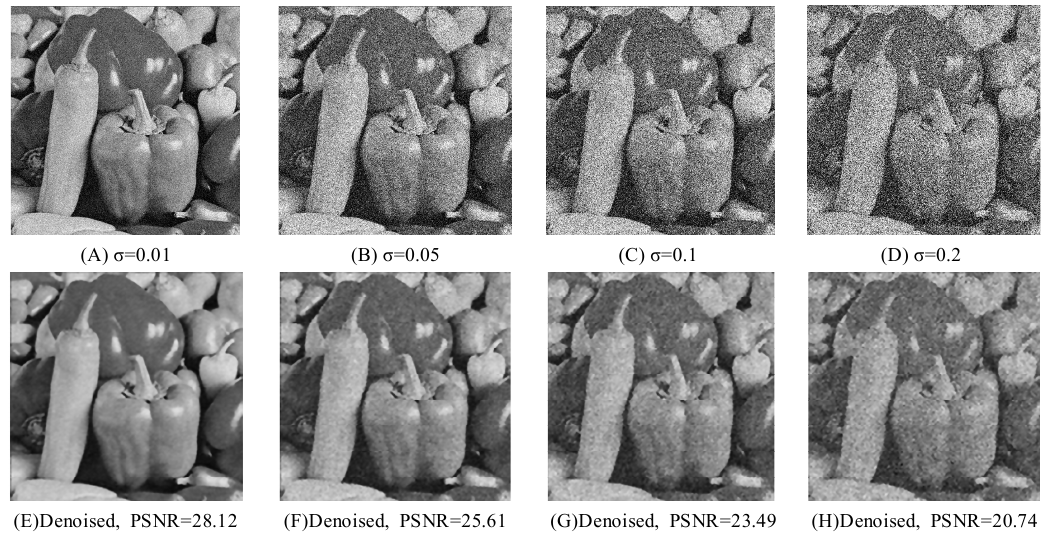
Figure 16. Denoising results of Peppers with Gaussian noise using IFOA ‐ DTCWT ‐ BF. (A) Peppers of noise σ = 0.01; (B) Peppers of noise σ = 0.05; (C) Peppers of noise σ = 0.1; (D) Peppers of noise σ = 0.2; (E) Denoised image of σ = 0.01; (F) Denoised image of σ = 0.05; (G) Denoised image of σ = 0.1; (H) Denoised image of σ = 0.2.